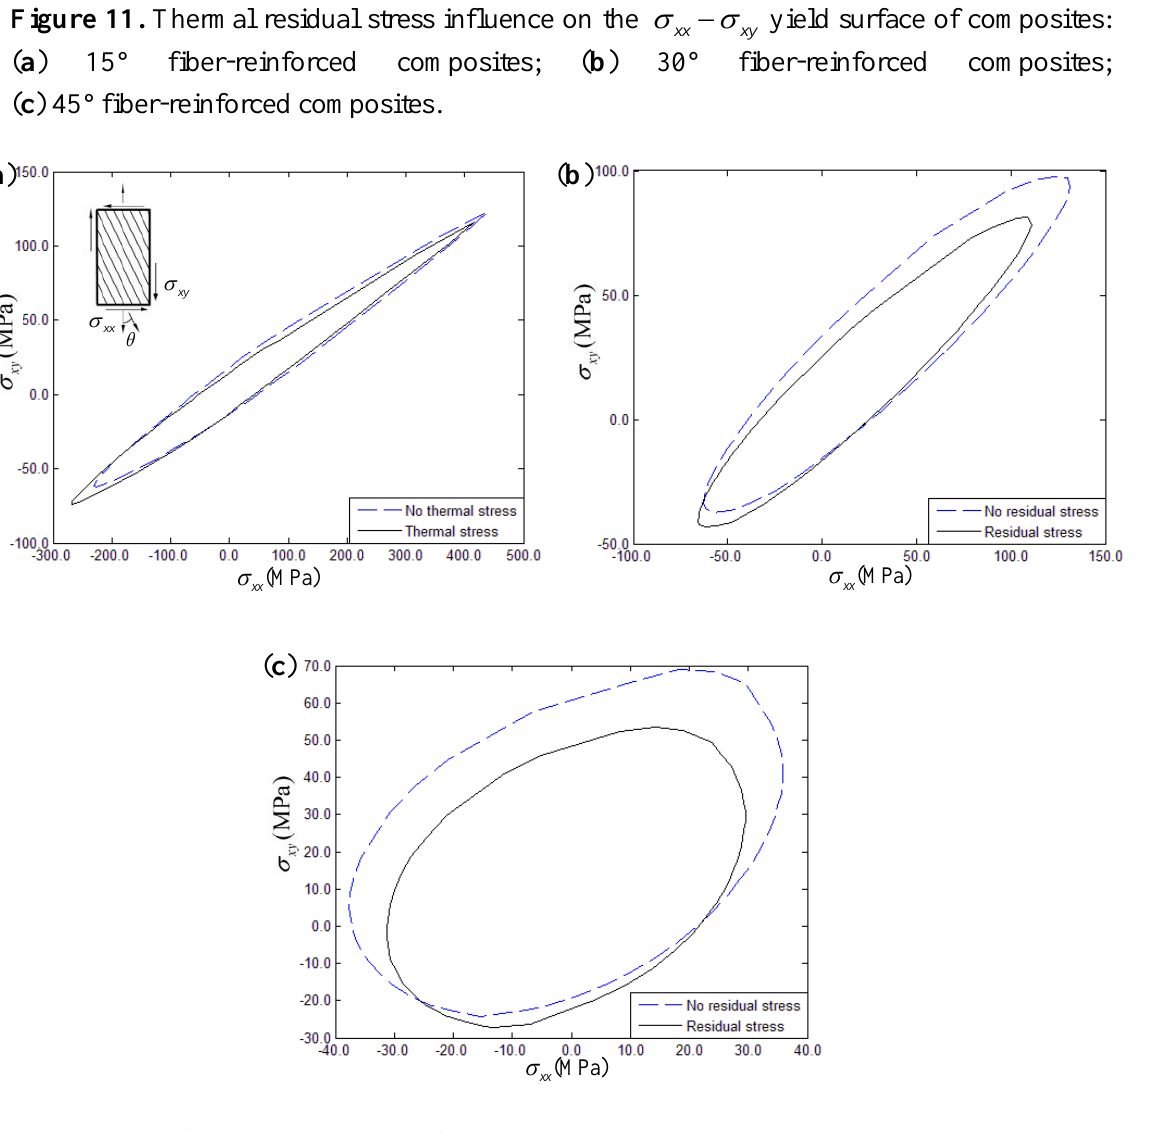
Figure 11. Thermal residual stress influence on the yield surface of